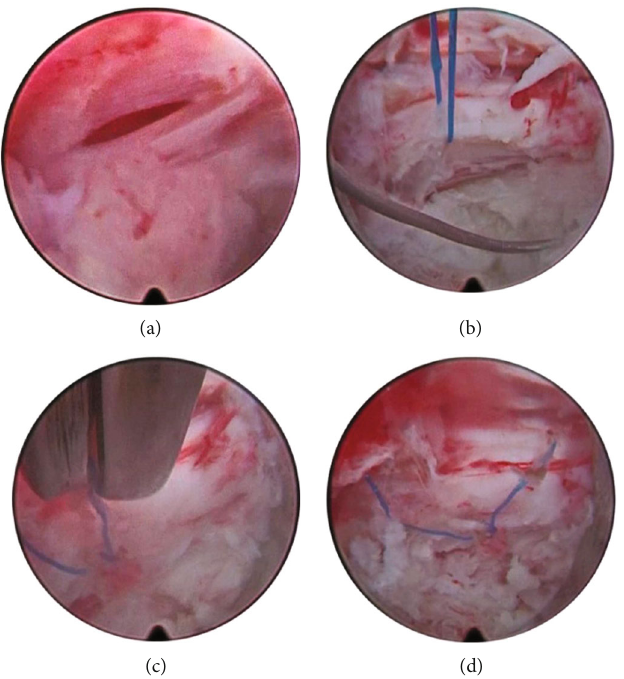
Figure 2: (a) Longitudinal dural tear of approximately 1cm. (b) Thread passed through the two edges of the lesion. (c) Threads cut with endoscopic scissors after tightening the knot. (d) Final aspect of the suture.